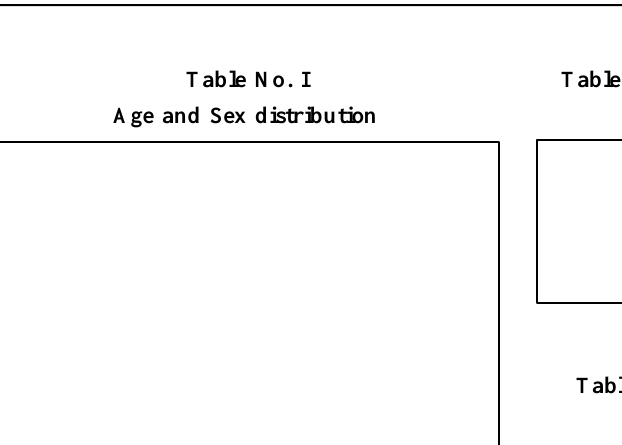
Table No. IV : Gastric adenocarcinoma